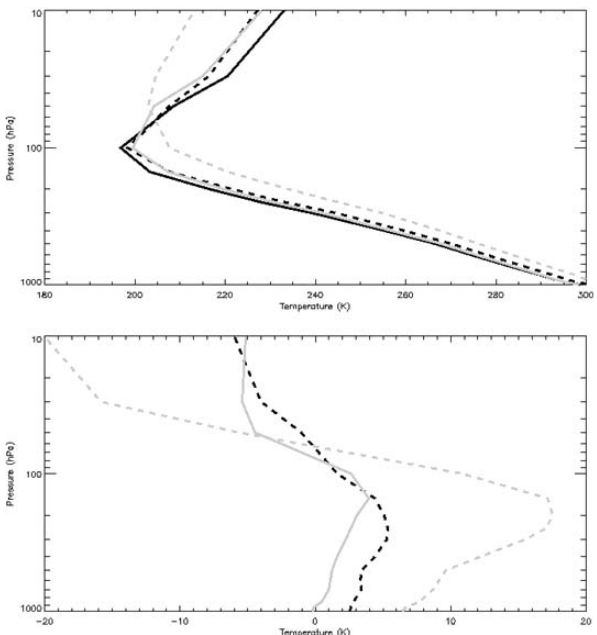
Fig. 2. Top panel: time-mean global-average vertical temperature profiles for STD1 (solid black); STD2 (dashed black); LEP1 (solid grey) and LEP2 (dashed grey); bottom panel: STD2 minus STD1 (dashed black); LEP1 minus STD1 (solid grey) and LEP2 minus STD1 (dashed grey).